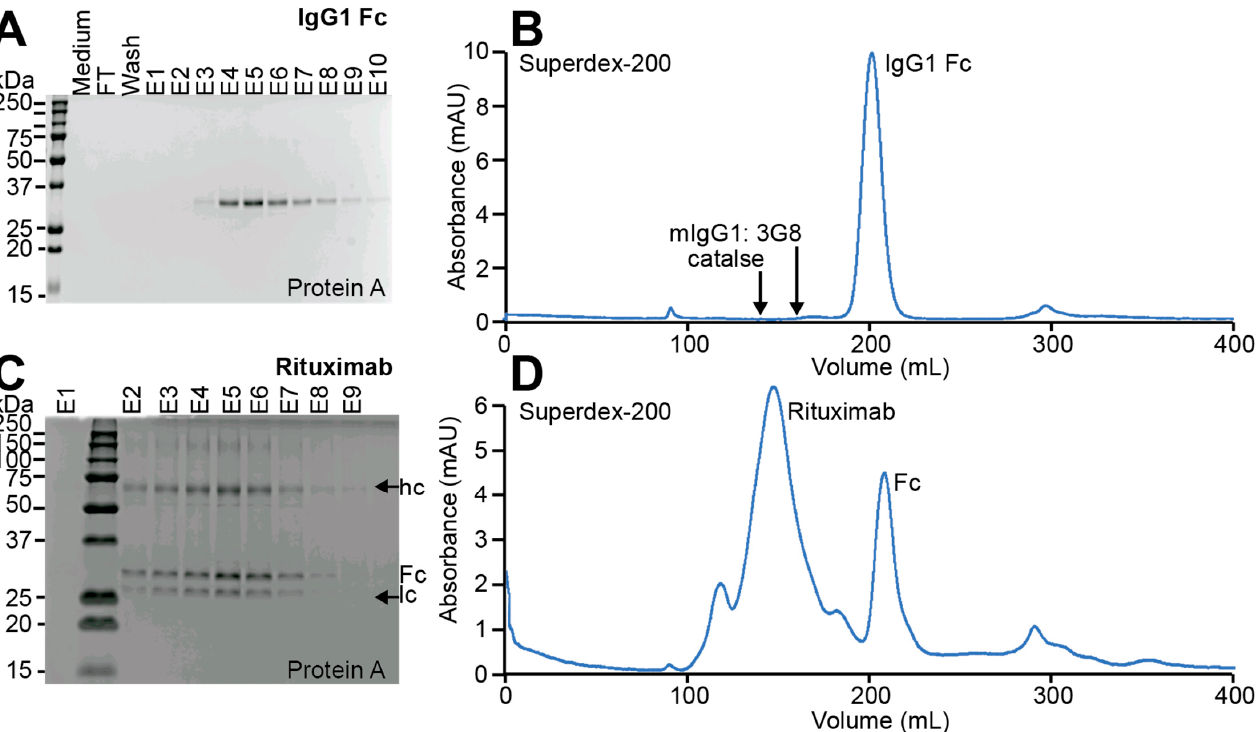
Figure 4. Purification of IgG1 Fc and Rituximab expressed from EBY100-(GPD)EndoS2. IgG1 Fc purified using Protein A chromatography ( A ) and size-exclusion chromatography ( B ). Rituximab purified using Protein A chromatography ( C ) and size-exclusion chromatography ( D ). The largest peak in D at 140 mL is Rituximab. Arrows indicate the Rituximab heavy and light chain. ( A , C ) are 12% reducing SDS-PAGE gels.